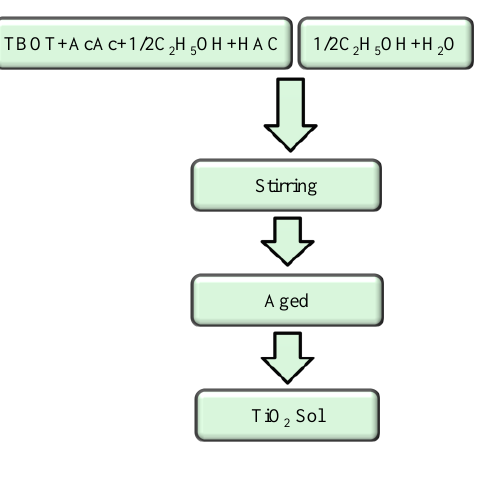
sol synthesis 2